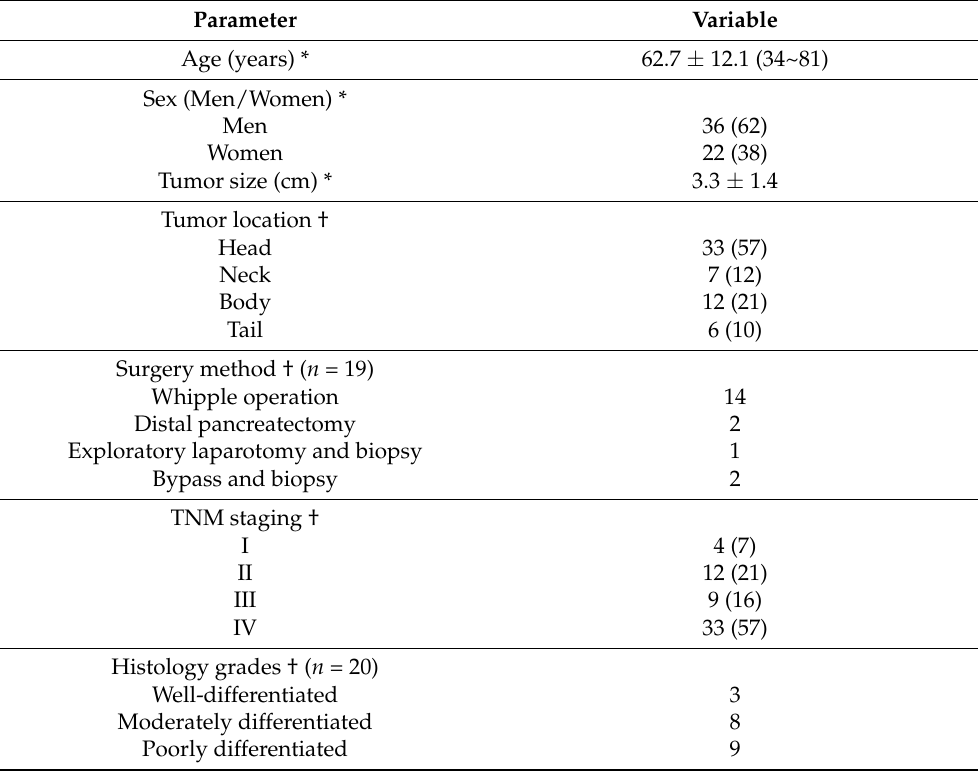
Table 1. Demographic and clinical characteristics of the 58 participants.